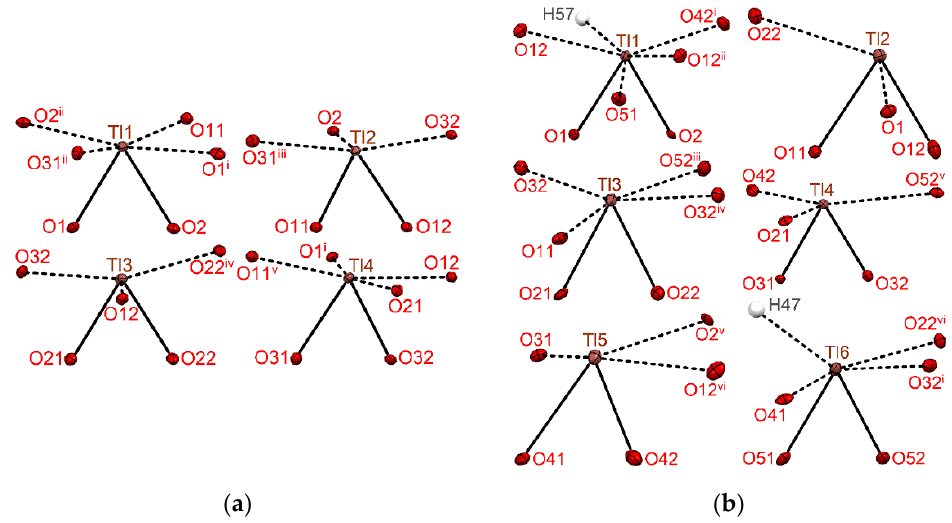
Figure 9. Coordination spheres of thallium(I) ions in compounds ( a ) 3 (symmetry codes as in Table 3) and ( b ) 4 (symmetry codes as in Table 4). Solid and dashed lines indicate chelating bonds and intermolecular contacts, respectively. Table 3. Selected bond lengths, distances (Å), and angles (°) for compound 3 .